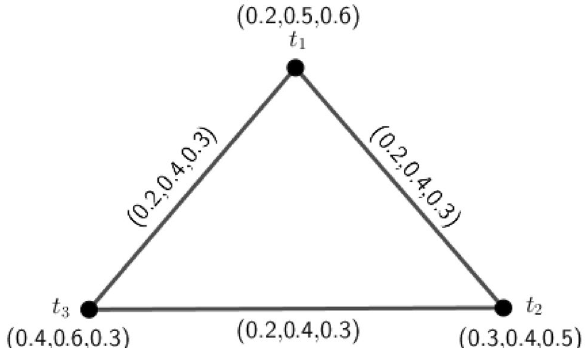
Figure 7. A 3PFG Γ 4 is a self-antipodal.